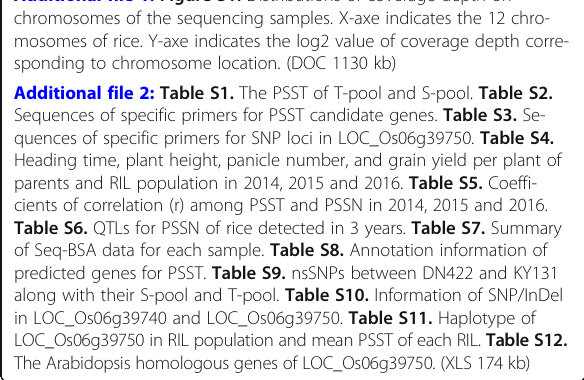
Table S6. QTLs for PSSN of rice detected in 3 years. Table S7. Summary of Seq-BSA data for each sample. Table S8. Annotation information